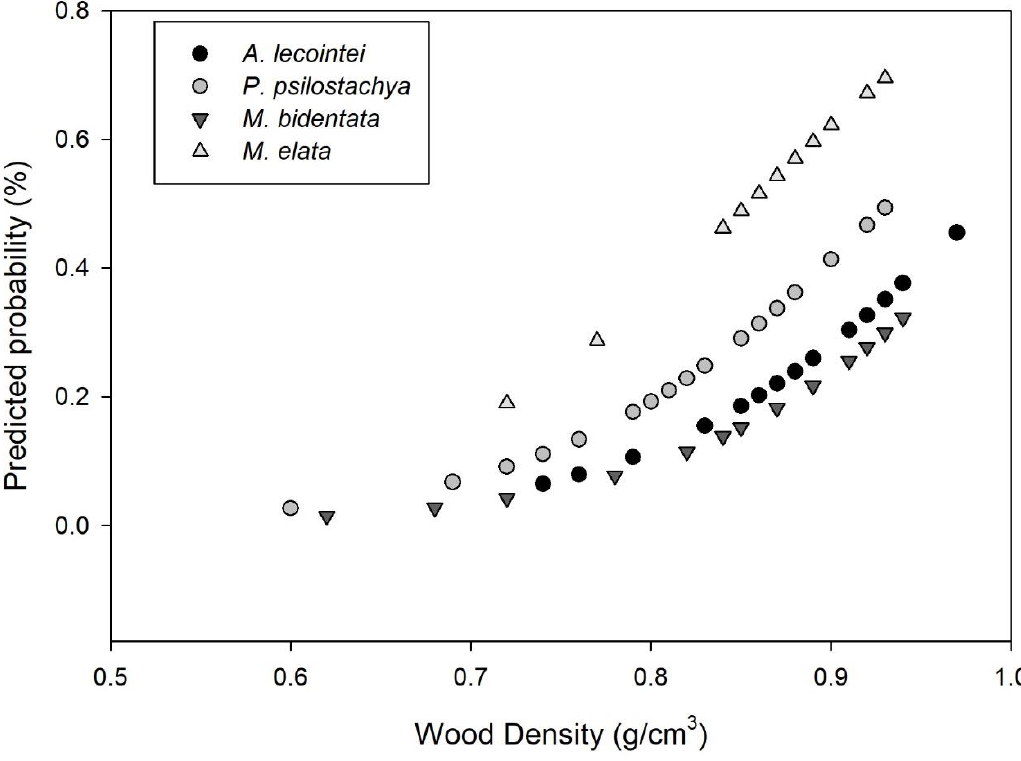
Figure 3. The probability of a tree hosting a Coptotermes testaceus colony as a function of wood density. Samples sizes were as follows: P. psilostachya and M. elata ( N = 30), M. bidentata ( N = 28), and A. lecointei ( N = 20). Table 4. Logistic regression estimates for the presence of Coptotermes testaceus colonies in heartwood hollows of the four tree species with N ≥ 20 individuals sampled: P. psilostachya and M. elata ( N = 30), M. bidentata ( N = 28), and A. lecointei ( N =